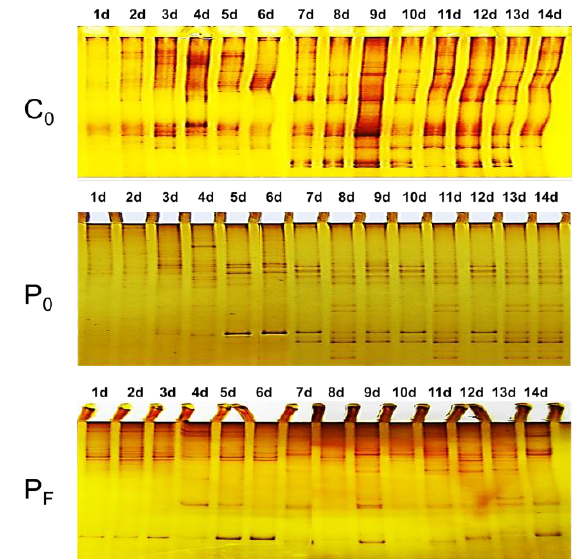
Figure 3. The Single-stranded Conformation Polymorphism (SSCP) patterns of the early biofilm- forming eukaryotic microbial communities developed on the C 0 , P 0 and P F surfaces.